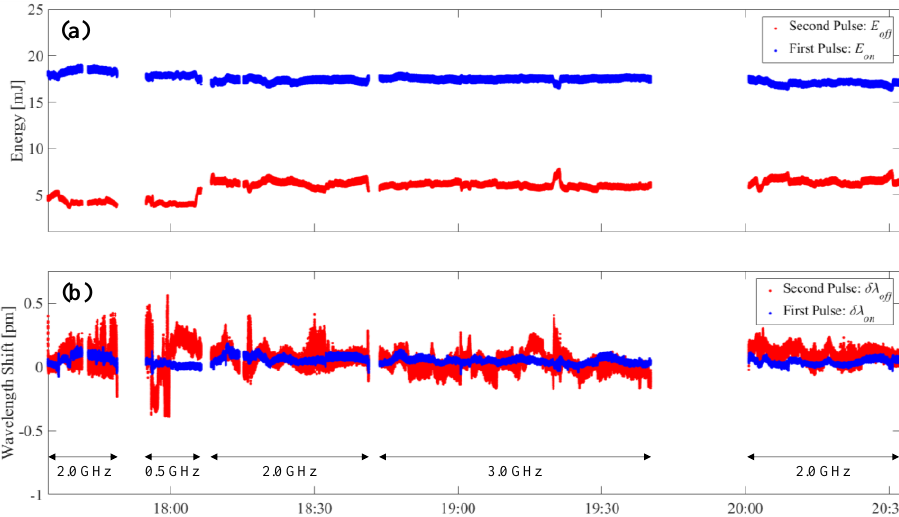
Figure 3. Continuous real-time monitoring for the 2-μm IPDA laser transmitter operation during 17 September 2019 flight. ( a ) Laser pulse energy variation records using the laser energy monitor. ( b ) Wavelength variation records, with respect to seeding wavelength setting, using heterodyne seeding monitor. Monitoring is conducted per shot, for on-line and off-line, set for the first and second pulses, respectively. Different on-line tuning, of 0.5, 2.0 and 3.0 GHz with respect to R30 line center, were used during airborne operations.